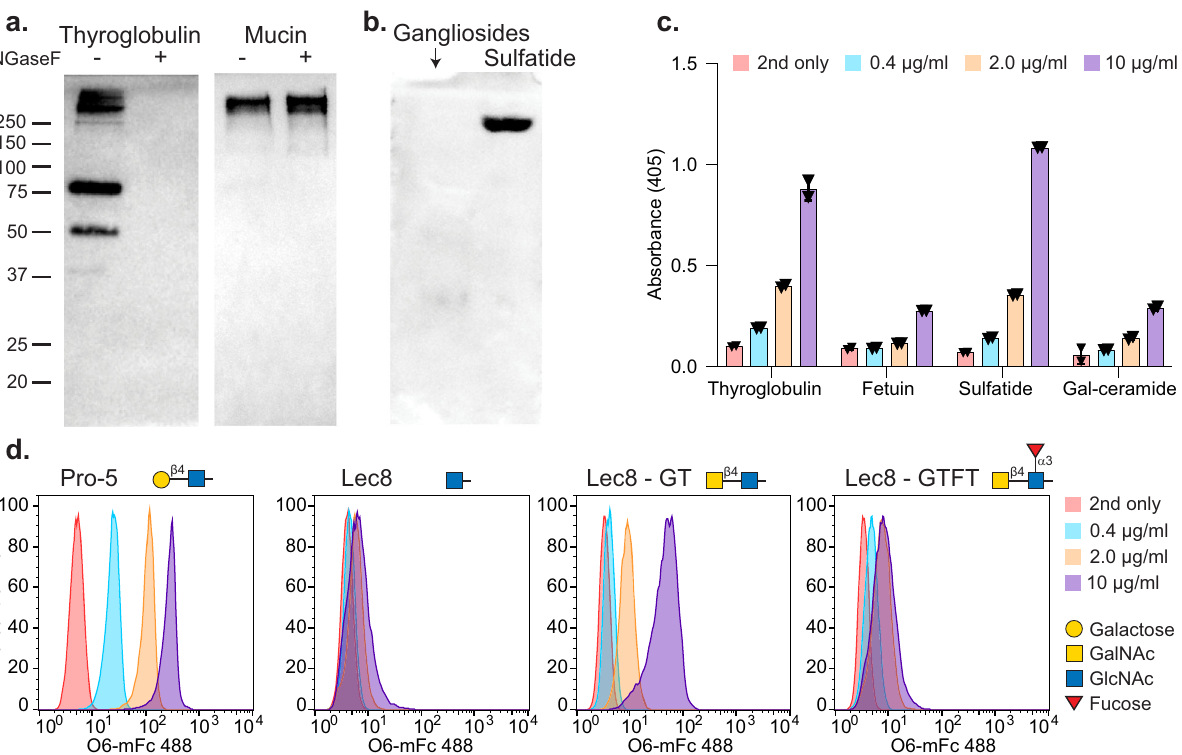
Fig. 3 The utility of chimeric VLRs for galactose-3-sulfate detection as demonstrated by western blotting, TLC-overlay, ELISA, and fl ow cytometry. a O6-mFc detects galactose-3-sulfate on the N-glycans of bovine thyroglobulin and O-glycans on human mucins. b O6-mFc bound to sulfatide and not porcine gangliosides in TLC-overlay. c Validation of b and c by ELISA, using O6-mFc at 4 concentrations. n = 2, each black triangle represents one data point, error bars = ±1 standard deviation. d Dose-dependent binding is observed by fl ow cytometry of Pro-5 CHO cells and not Lec8 mutants. Lec8GT CHO cells are positive; however, addition of α 1-3 linked fucose to the LDN motif abrogates binding in Lec8GTFT